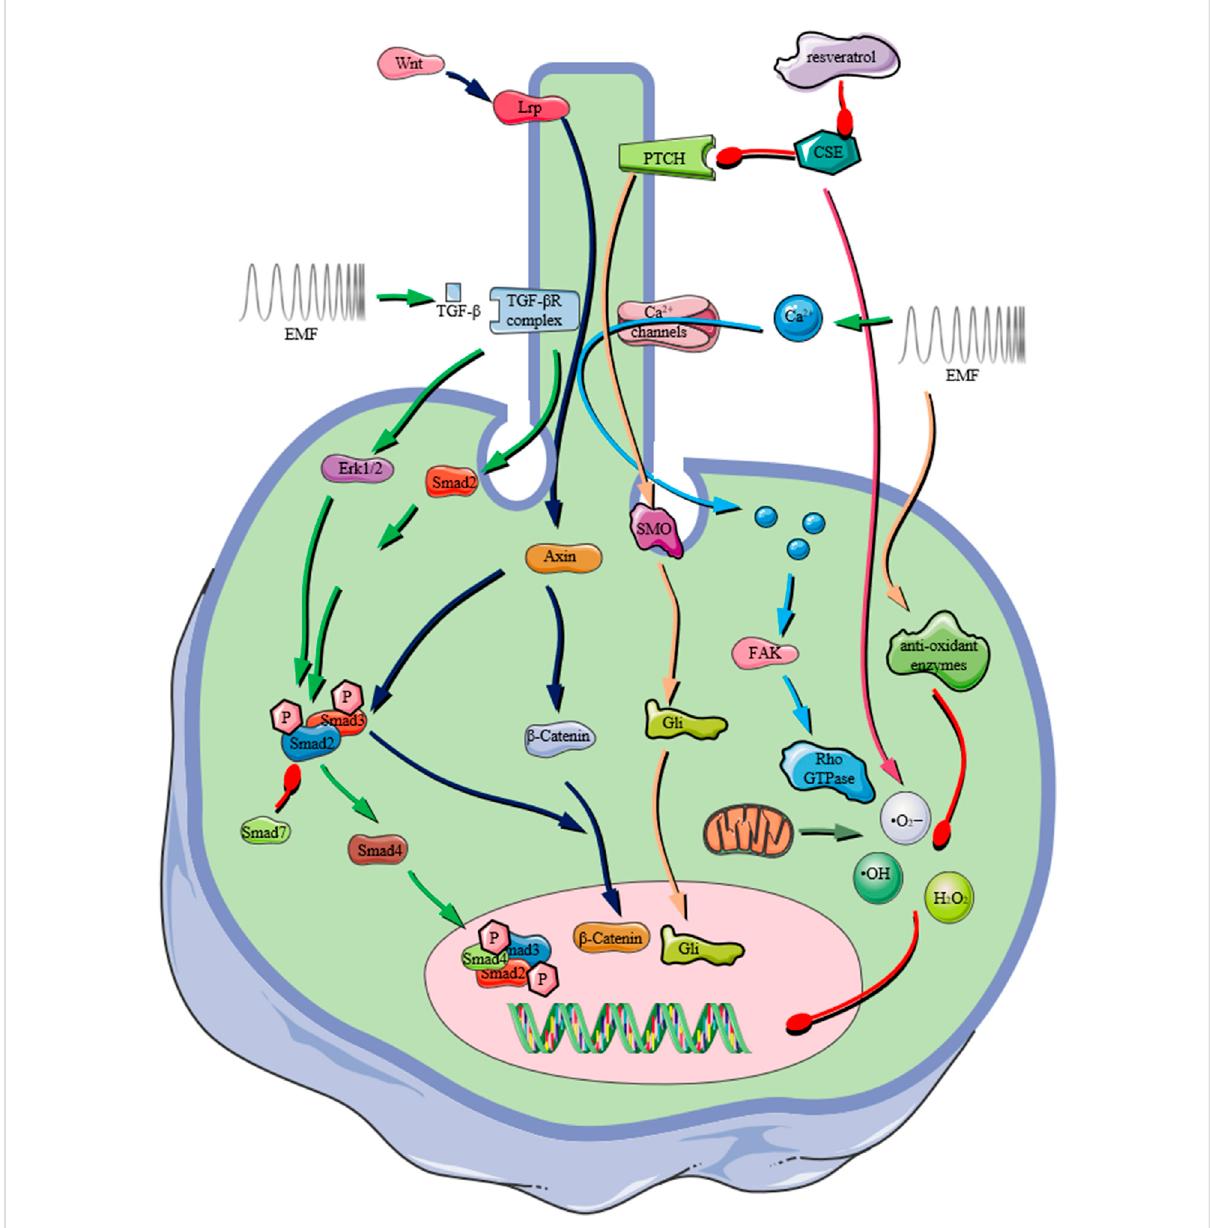
FIGURE 3 Schematicrepresentationoftheimportantrolethattheprimaryciliumplaysinreceivingextracellularphysical/chemicalstimuliandtransducing them by various signaling pathways, e.g. , TGF- β signaling pathway, Wnt/ β -Catenin signaling pathway, Ca 2+ in fl ux mediated signaling, ROS production. In recent years, PEMF exposures were reported to activate various signaling pathway depending on the presence of primary cilium on osteoprogenitors (The graphic components of the fi gure were provided by